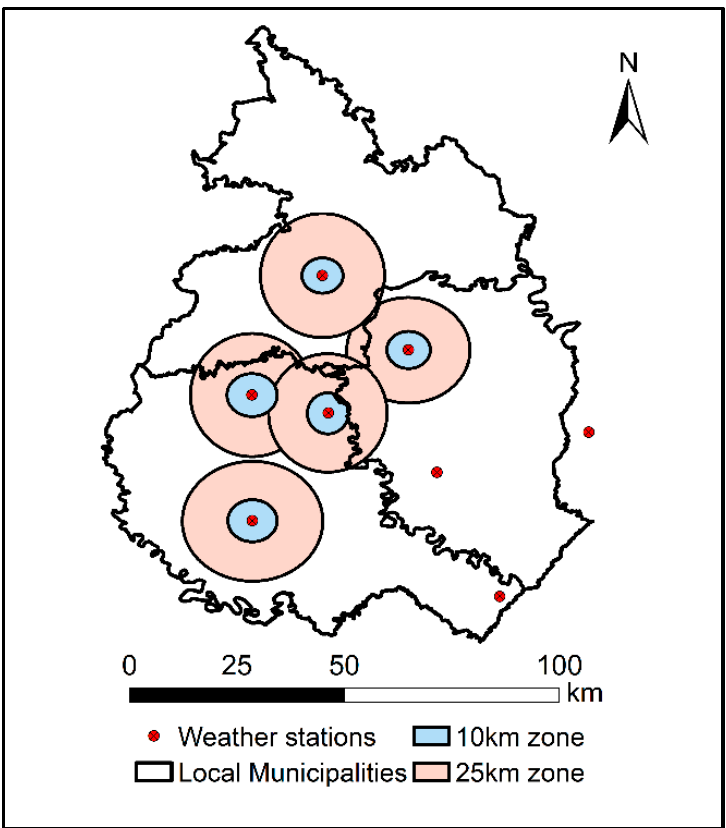
Figure 2. WSs and the spatial scales at which analyses were performed. Source: adapted from [26].